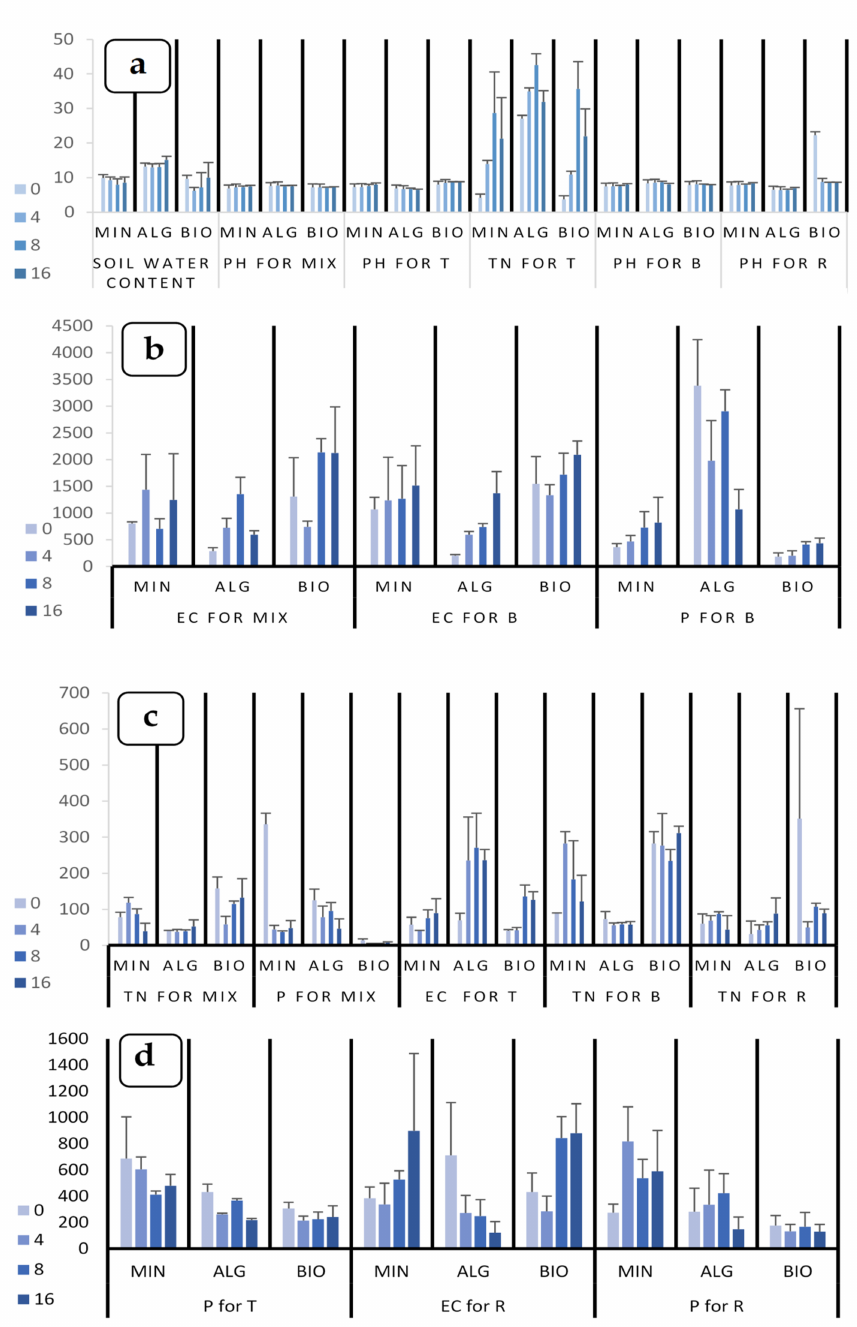
Figure 6. The effects of salinity stress and fertilizer types on soil parameters during the early growth stage (7 weeks) for Rehan barley cultivar. MIN: mineral fertilization, BIO: biochar with mineral fertilization, ALG: dried algae biomass powder from freshwater; 0, 4, 8, 16 mS/cm EC are the salinity concentrations in soil. EC = electric conductivity, TN = total nitrogen (mg/kg), P = phosphate (mg/kg), T = top soil sample, B = bottom soil sample, R = rhizosphere soil sample, mix = mixed soil sample. The mean value and standard deviation are shown. The data have been arranged to put